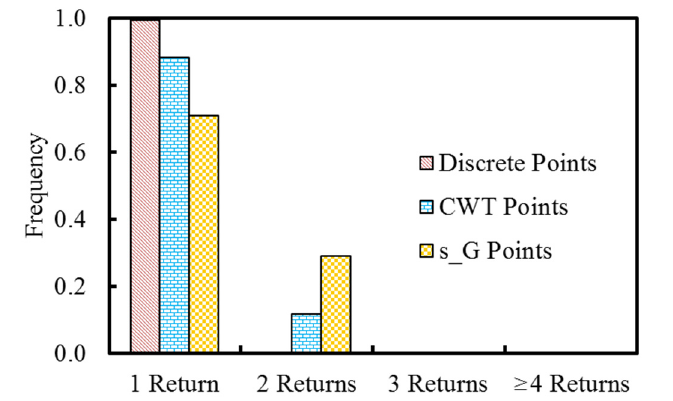
Figure 9. Distribution of the number of full waveform returns using different peak detection methods for the Snake River. CWT and s_G methods are better able to detect multiple returns while almost all discrete points are single return.